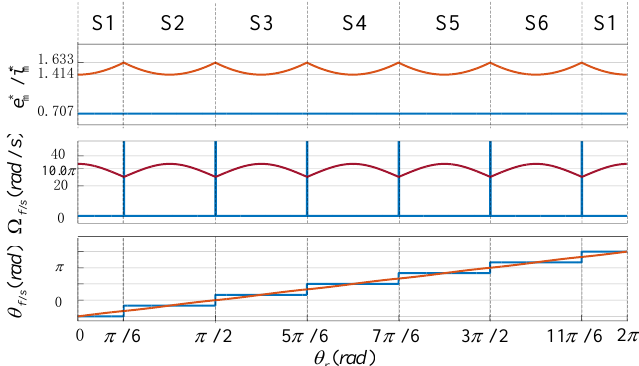
Figure 3. The waveforms of vector modulus, angular velocity, and angle with square-wave current control (SWC): ( up ) modulus of current vector (blue) and back-EMF (red); ( middle ) angular velocity of current vector (blue) and back-EMF vector (red); ( down ) angles of current vector (blue) and back-EMF vector (red).